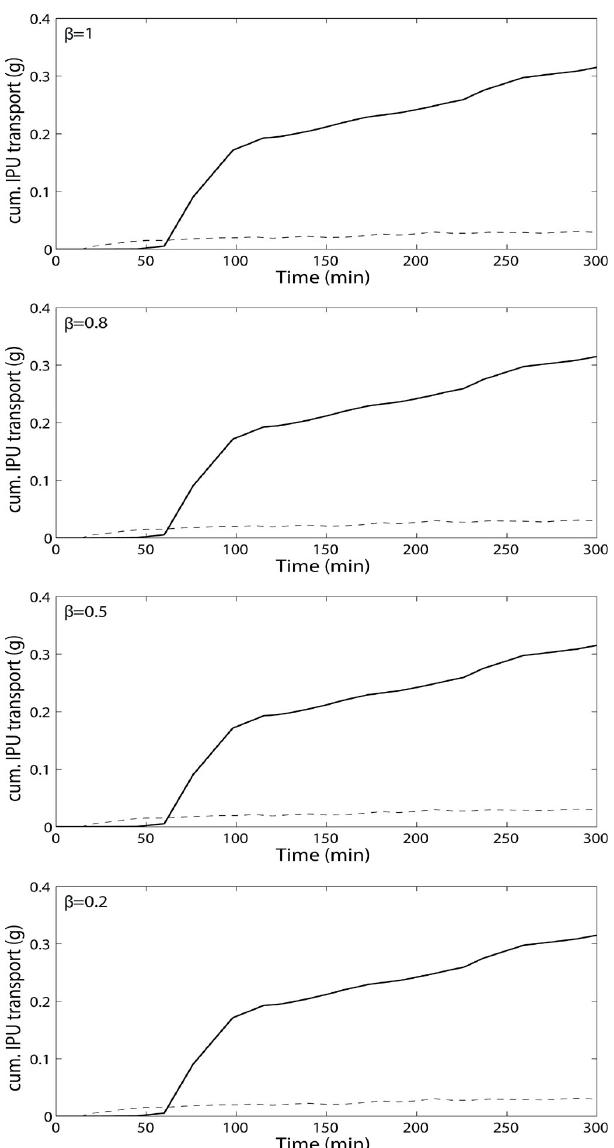
Fig. 7. Cumulated IPU loss plotted against simulation time for dif- ferent parameterisations of the Freundlich isotherm. The solid line presents the observed IPU leaching, the dashed lines model runs with different parameterisation of the Freundlich parameters. Ev- ery plot includes eight model realisations with a fixed value for the Freundlich exponent β and varied values for the Freundlich coeffi- cient k f between 0.26 and 20 l β g − 1 g 1 − β (lowest line) within 9 steps.